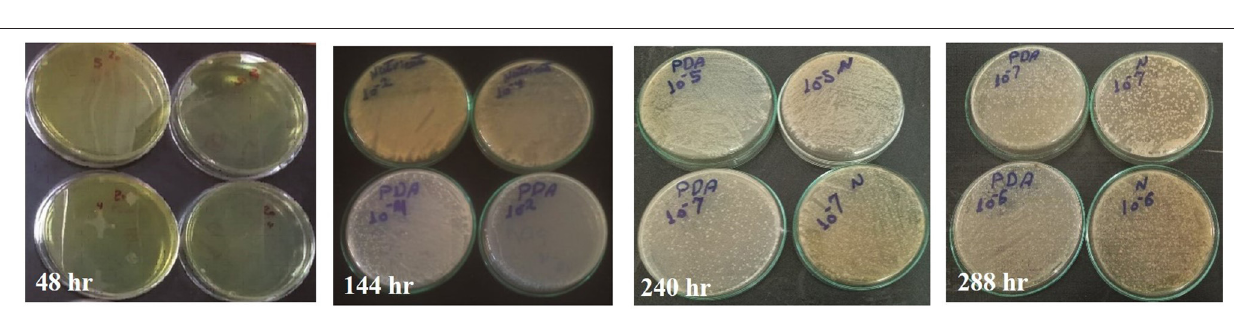
Frontiers in Nutrition |